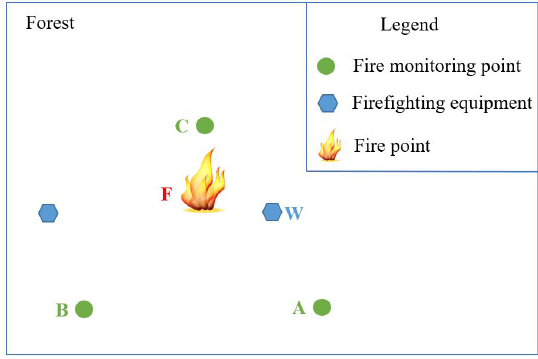
Figure 14. Sketch map of forest